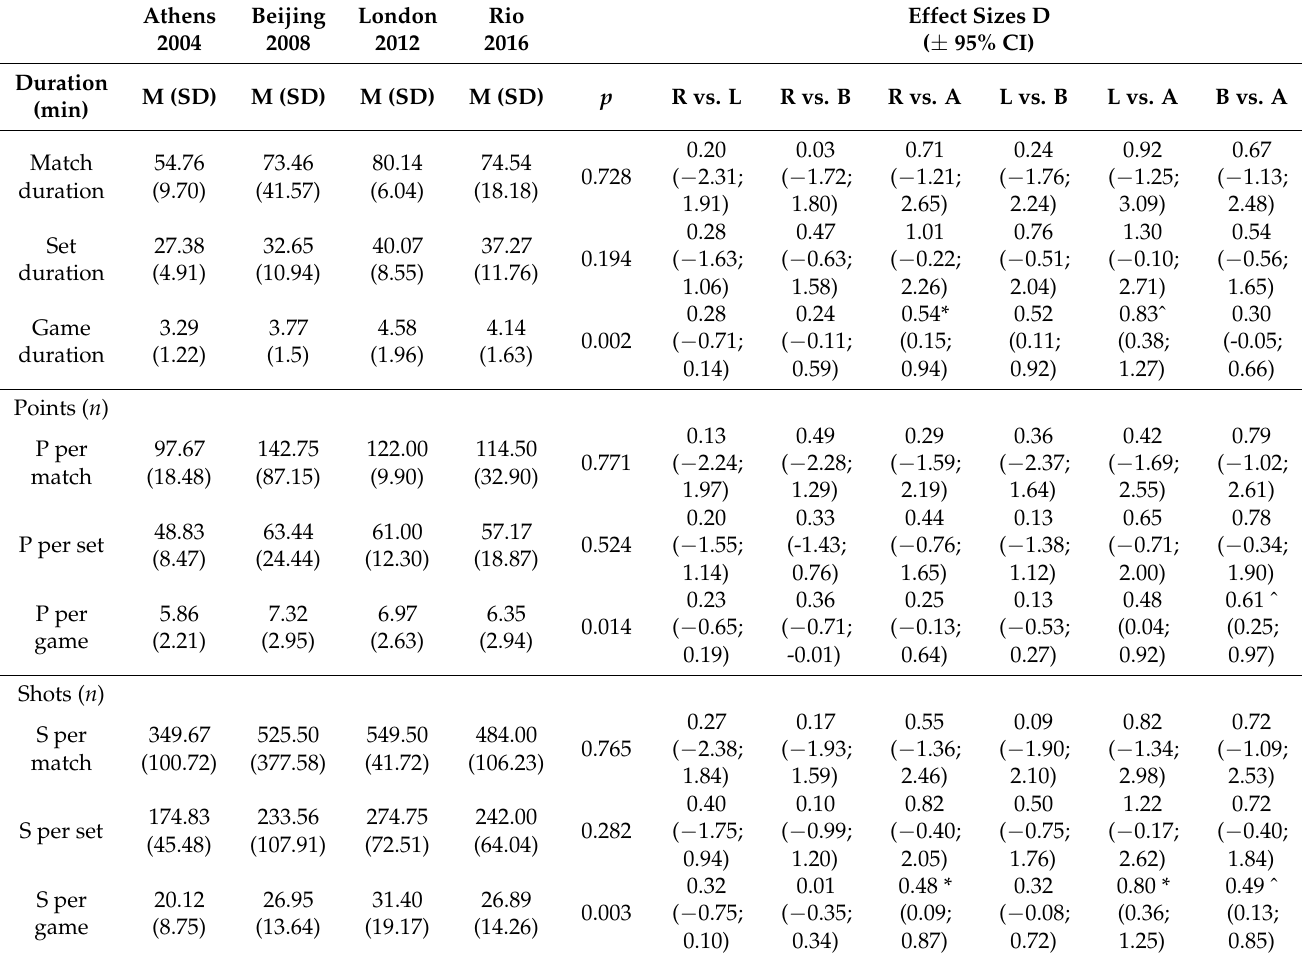
Table 1. Differences in Activity Patterns in Athens, Beijing, London and Rio Paralympic